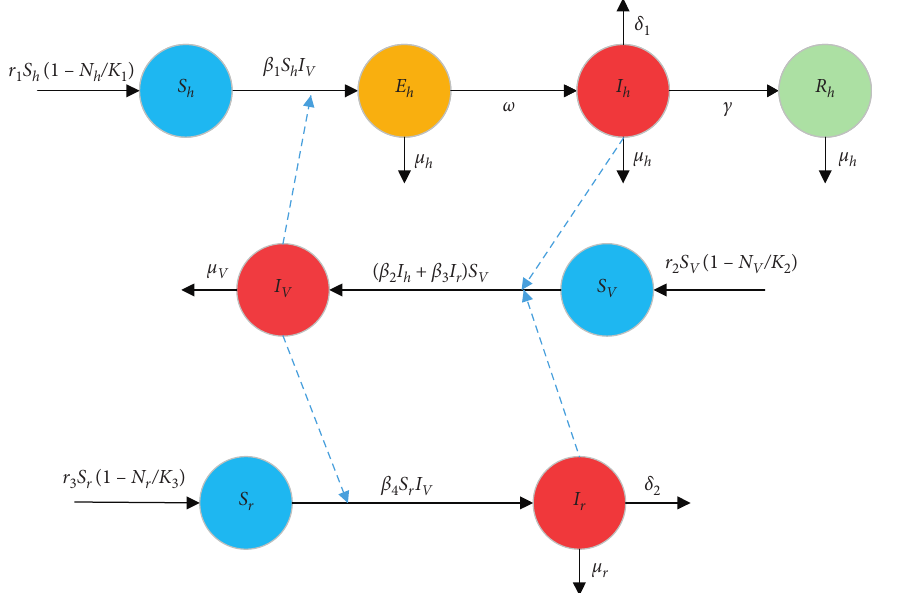
Figure 2: Flow diagram of the VL transmission